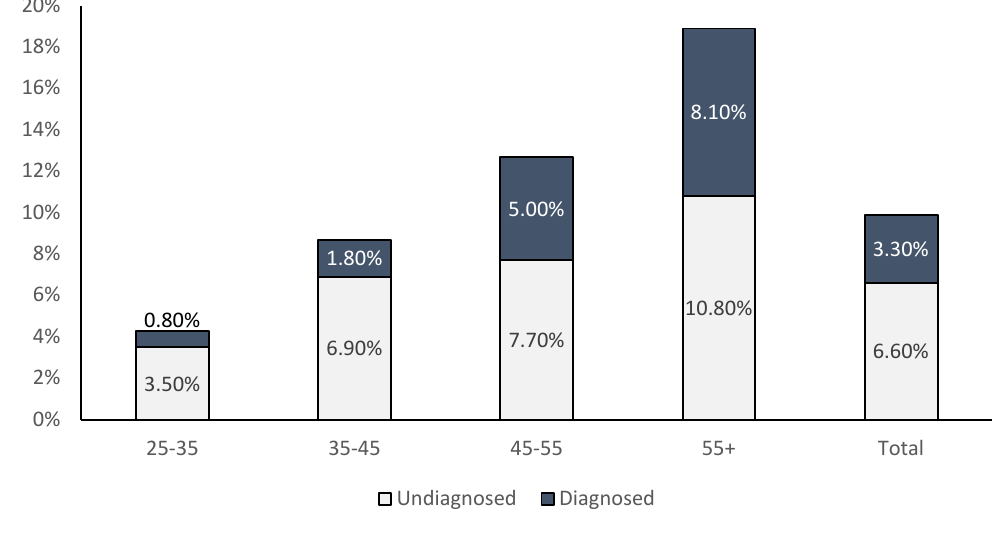
Figure 2. Prevalence of diagnosed and undiagnosed diabetes by age